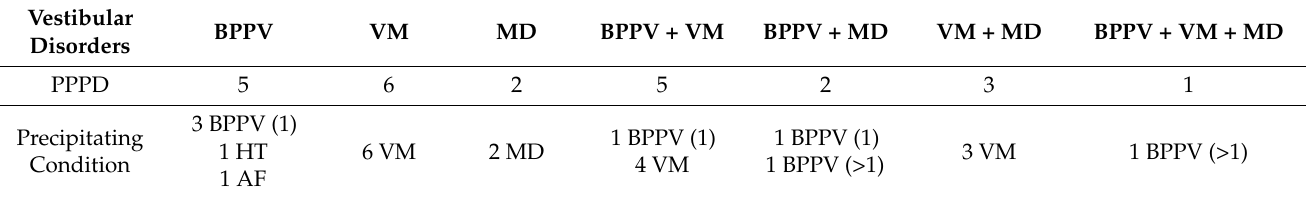
Table 3. Distribution of the precipitating condition. Persistent Postural Perceptual Dizziness was diagnosed in 24 cases among the 376 patients recruited with clinical history of single or